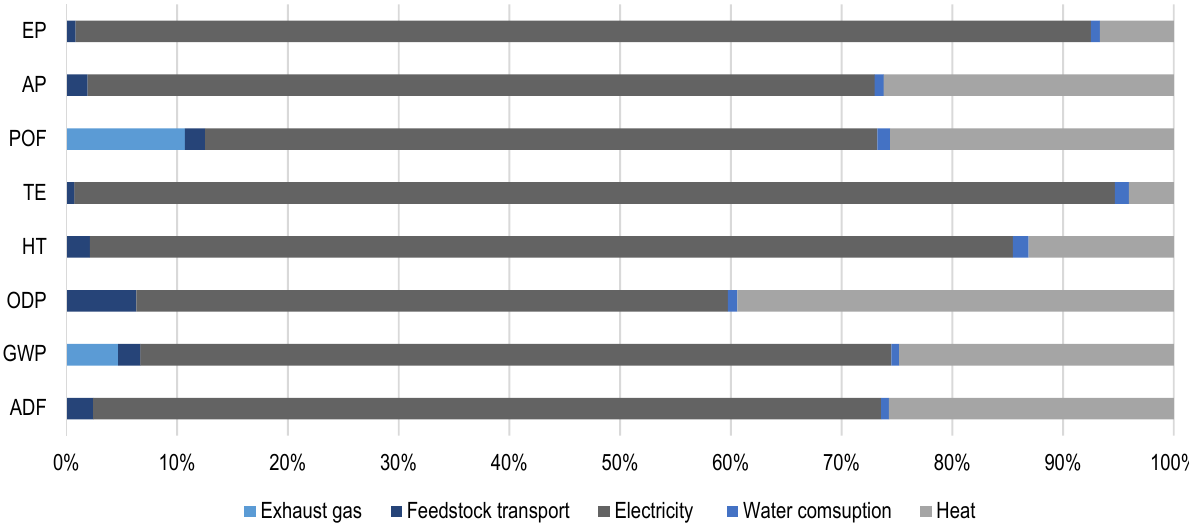
Table 5. Environmental impact categories evaluated a .